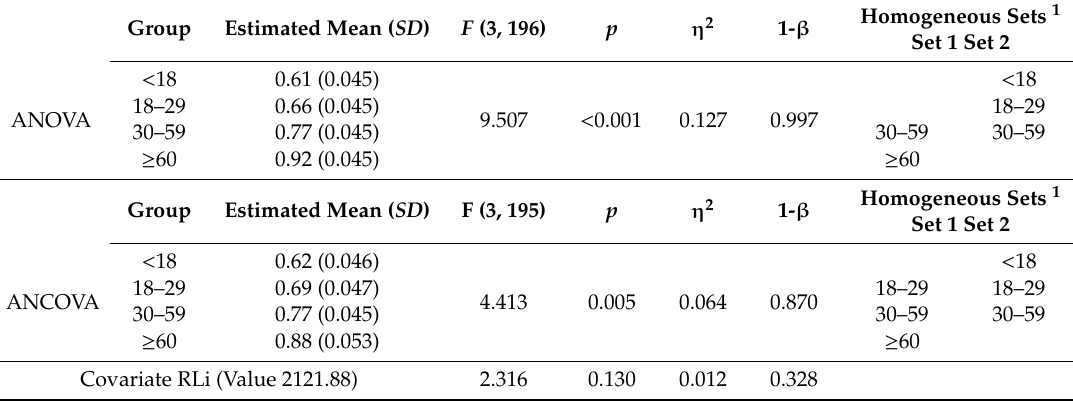
Table 4. D-scores in GV-IAT: ANOVA and ANCOVA di ff erences between age groups. Group Estimated Mean ( SD